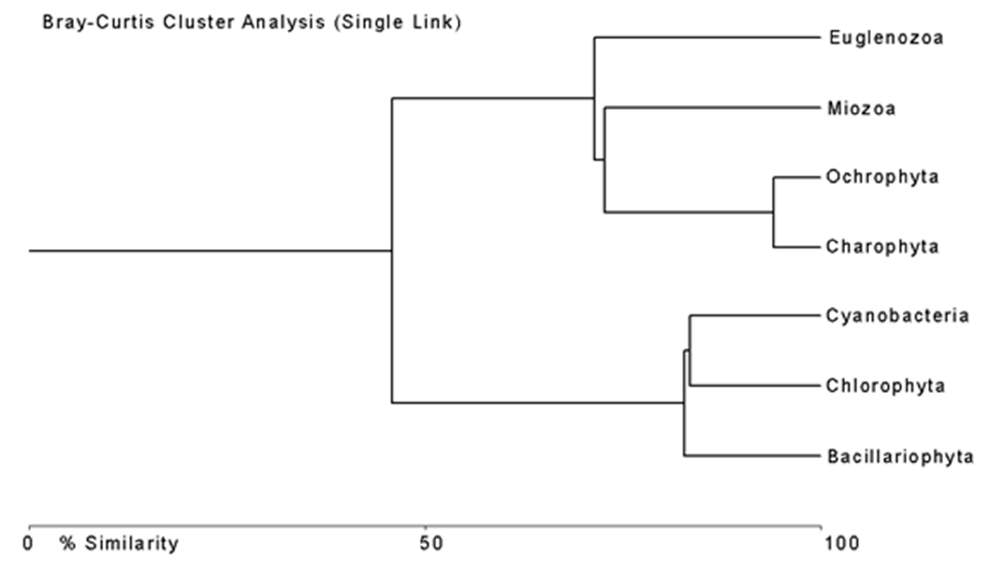
Figure 3. Cluster dendrogram of phytoplankton community species richness in the Lake Borovoe, 2019.